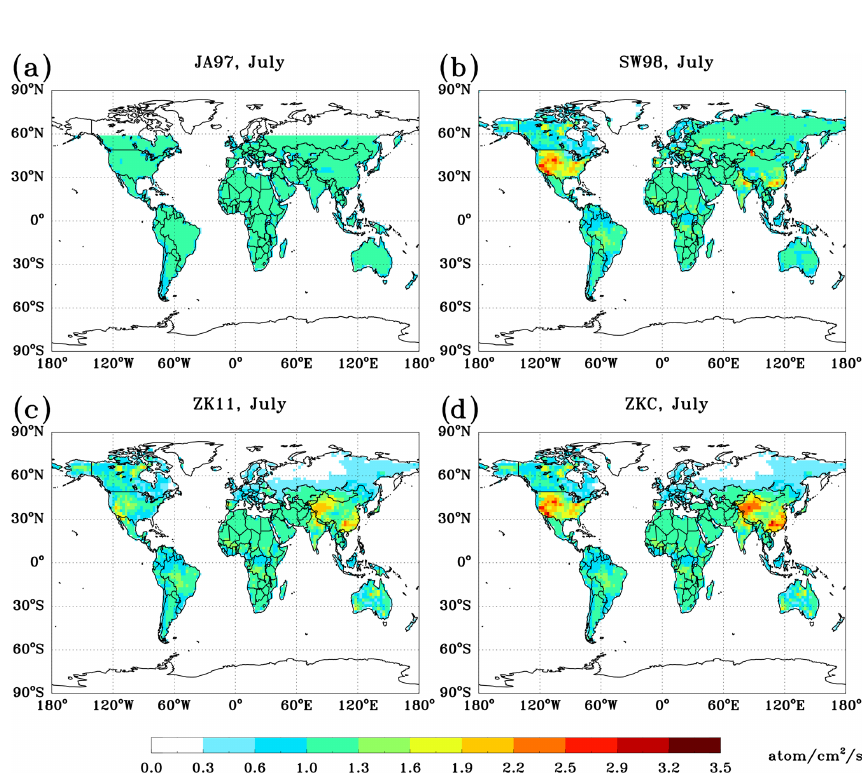
Figure 3. Same as Fig. 1 but for